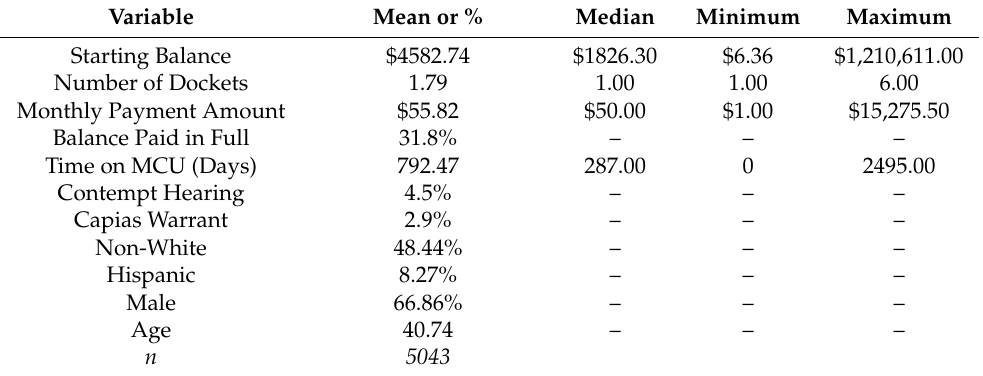
Table 1. Sample Descriptive